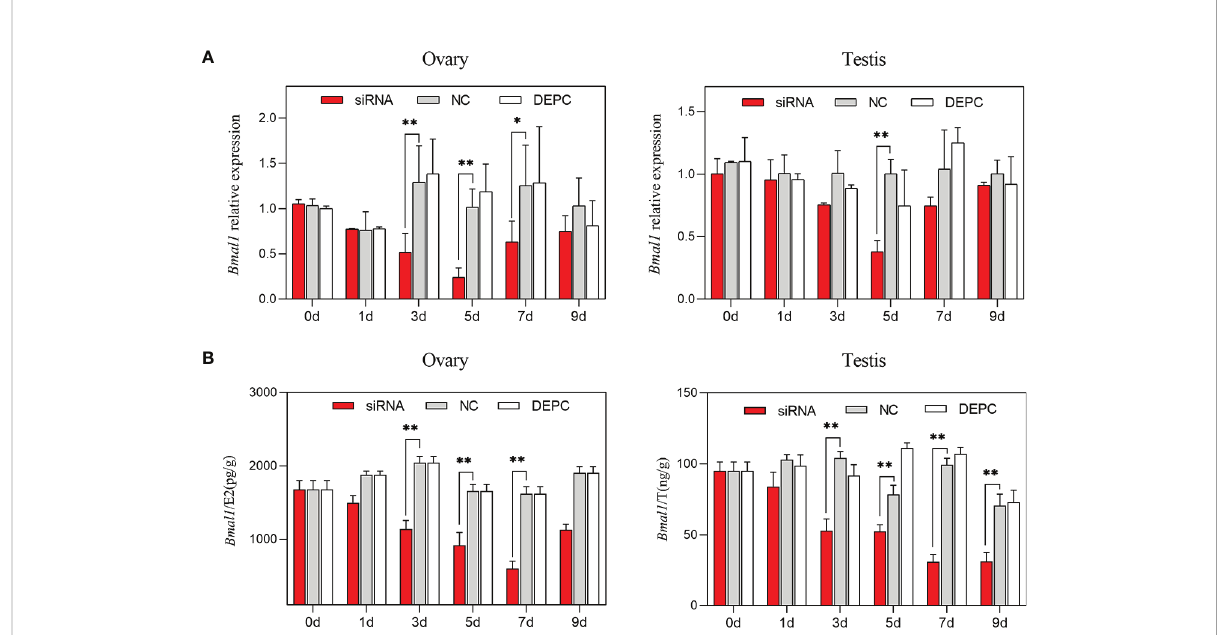
FIGURE 6 Gene expression of Bmal1 and sex hormone secretion after siRNA interference. (A) Relative expression of Bmal1 in the ovary and testis in siRNA group, NC group, and DEPC groups after siRNA interference (n=6). (B) The sex hormone content changes among groups after siRNA interference (E2, estradiol; T, testosterone; n=6). Asterisks indicate signi fi cant differences: * P < 0.05, and ** P < 0.01.